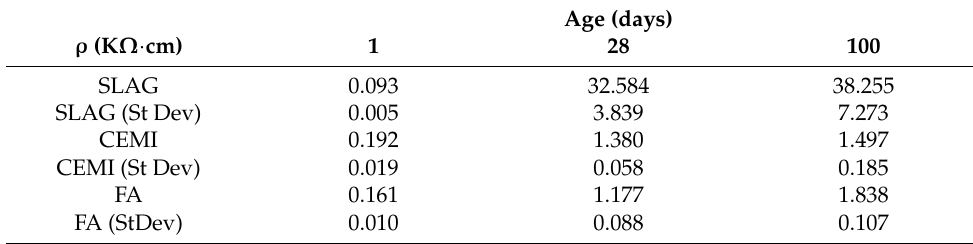
Electrical resistivity at the age of 24 h, 28, and 100 days. Averaged values of six